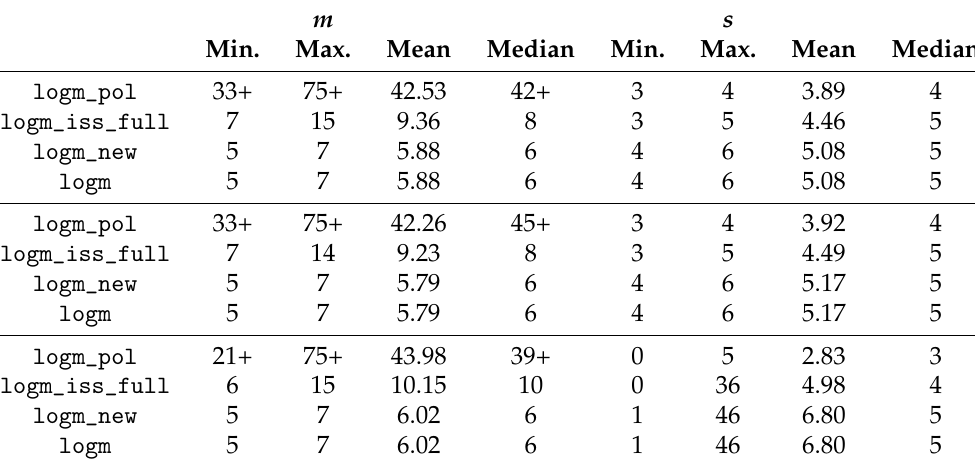
Table 6. Minimum, maximum, mean, and median values for the parameters m and s reached by logm_pol , logm_iss_full , logm_new , and logm for Sets 1–3, respectively.